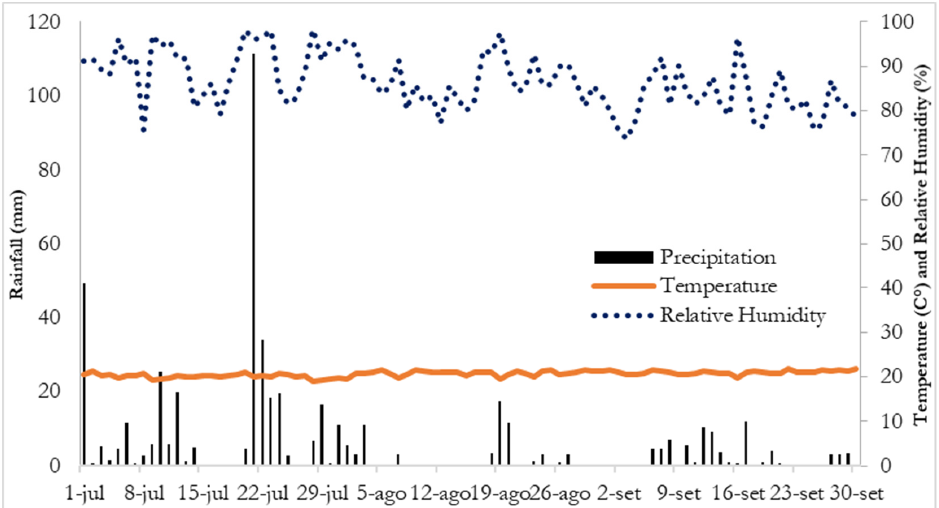
Figure 1. Rainfall, temperature and relative humidity at the Meteorological Station of the